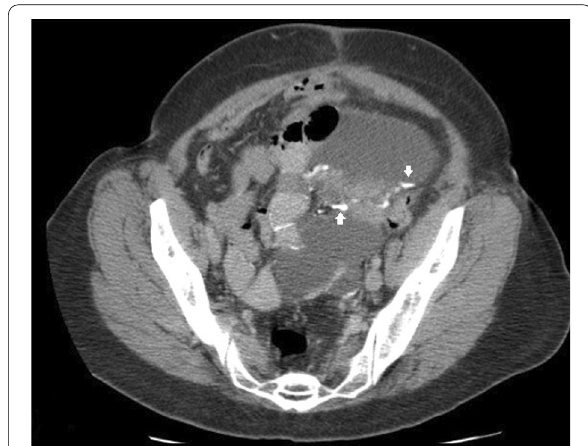
Fig. 3 CT axial image of a 47-year-old male patient with cystic mesothelioma showing nodular calcifications along the cyst walls